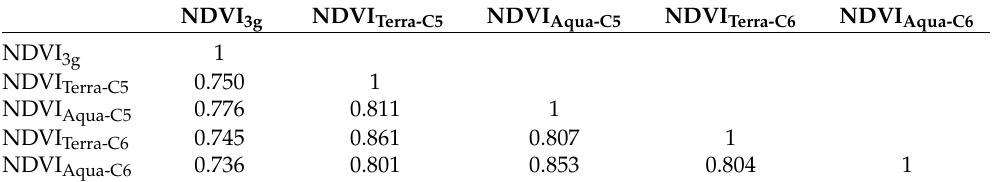
Table 1. Mean IOA s for all possible product combinations (see e.g., Figure 1b for pixel-wise IOA s between NDVI 3g and NDVI Aqua-C5 from which the mean value of 0.776 denoted herein is calculated). IOA s involving NDVI 3g is calculated from the MODIS CMG products (Section 2.2.1), whereas MODIS-only IOA s is derived from the 250-m